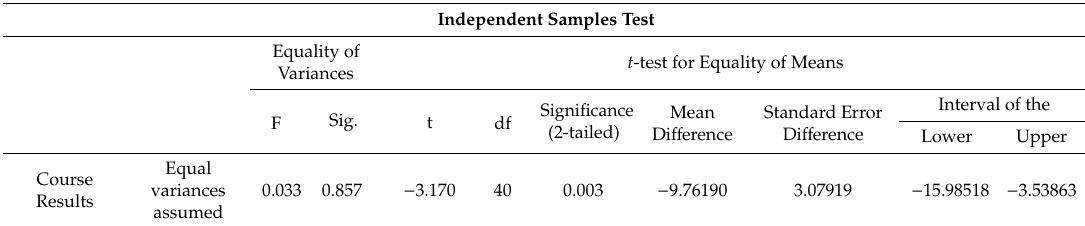
Table 7. Student learning outcomes—independent samples t -test